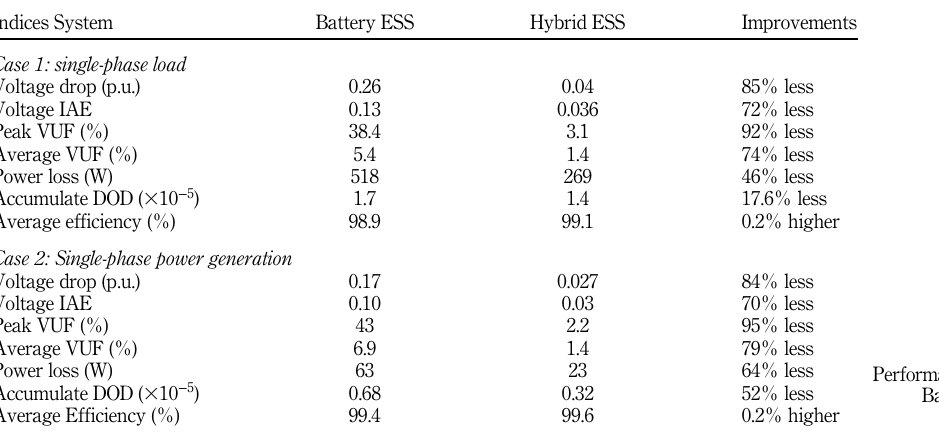
Table 3. Performance indices of Battery ESS and Hybrid